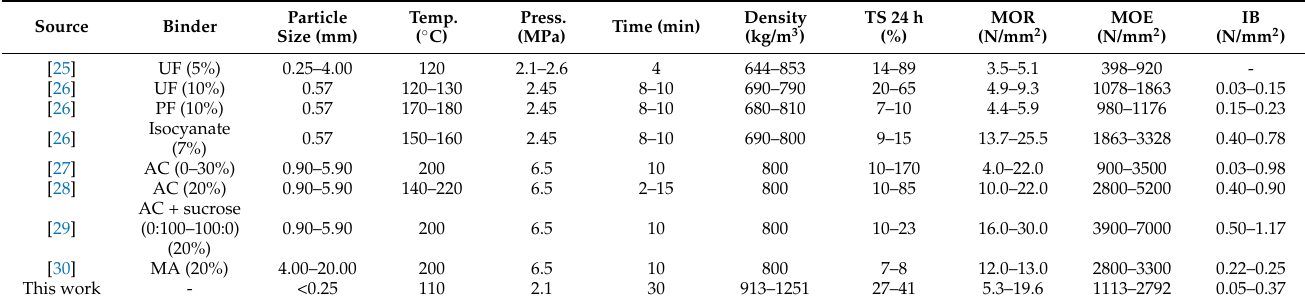
Table 6. Properties obtained for particleboards made from sorghum